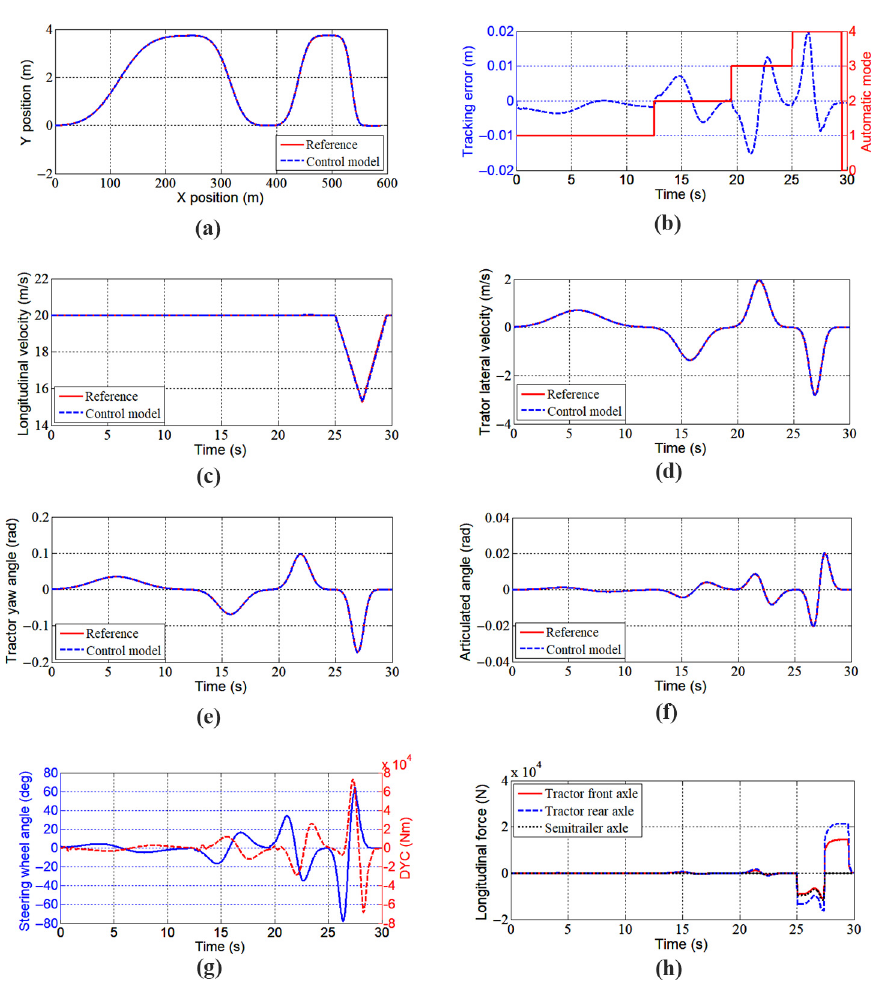
Figure 10 Control effects in different modes for anti-collision on a straight